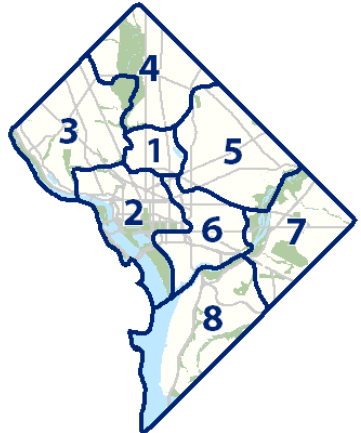
Figure 8. Map of the 8 wards of Washington, DC,